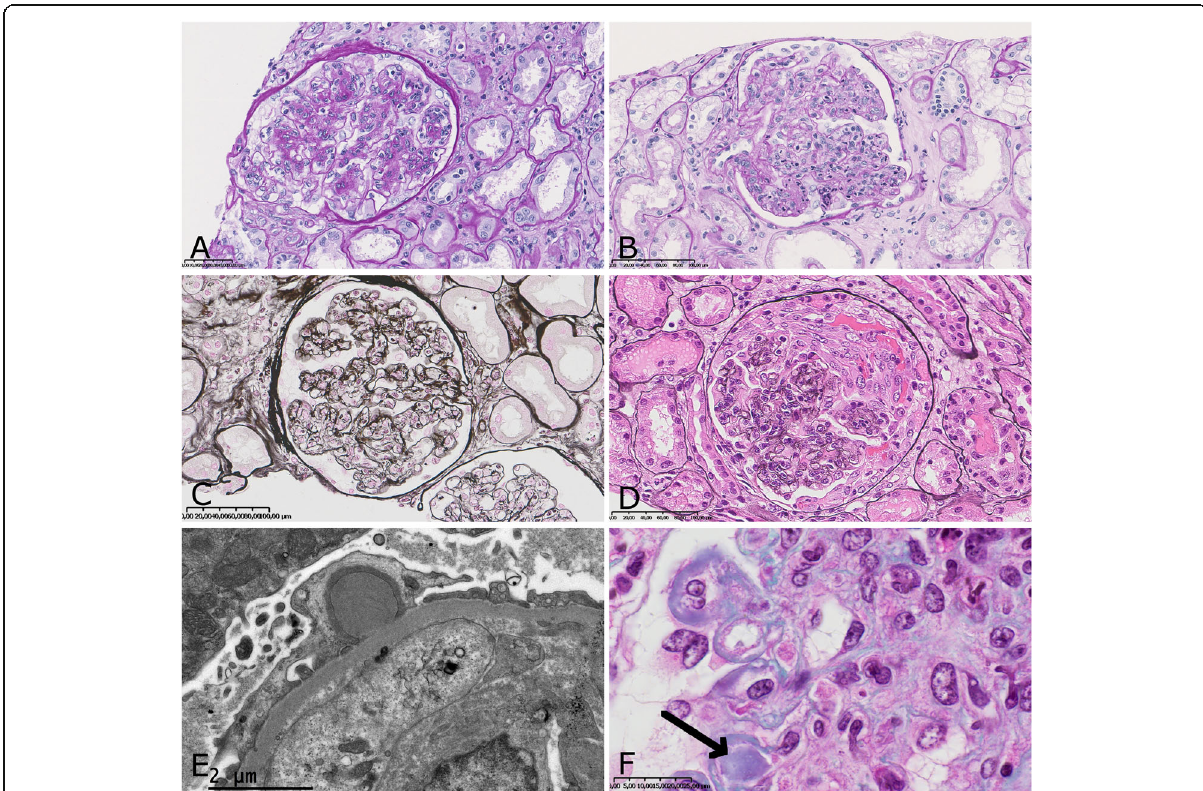
Fig. 1 Microscopy. a : mesangial with endocapillary proliferation was the most frequent pattern (Jones silver stain × 300); b : exudative endocapillary proliferation (PAS stain × 200); c : membranoproliferative glomerulonephritis (Jones silver stain × 200); d : crescentic proliferation with fibrinoid necrosis (Jones silver stain × 300); e : subepithelial humps deposit (electron microscopy × 20.000); f : subendothelial deposits with hyaline thrombus resembling cryoglobulin (arrow) (Masson ’ s trichrome stain × 1000)